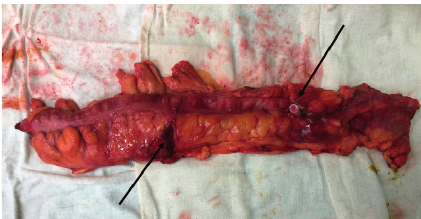
Figure 3: Resected descending colon showing multiple perfora- tions (arrows).